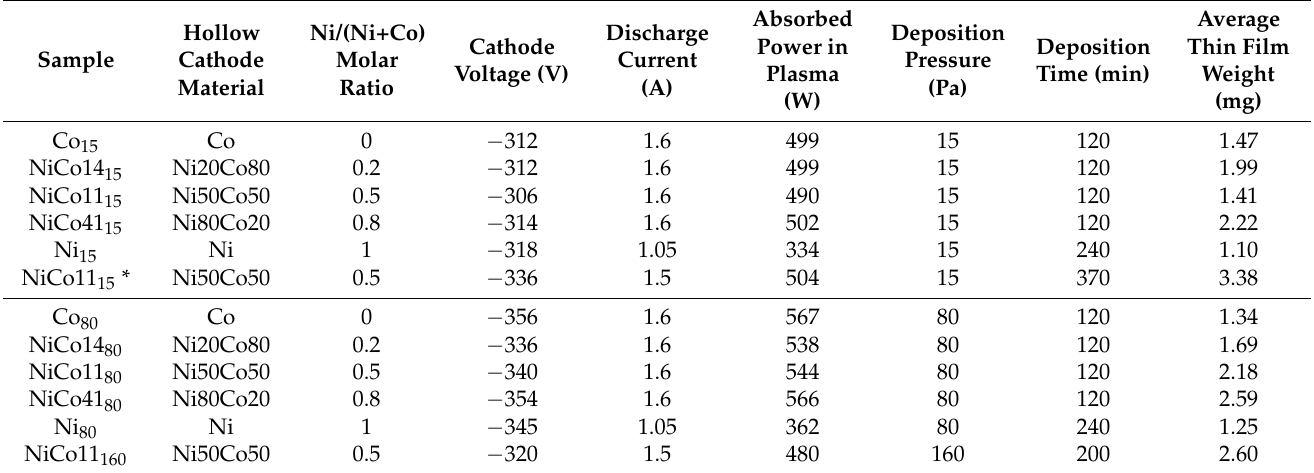
Table 7. Conditions of catalyst